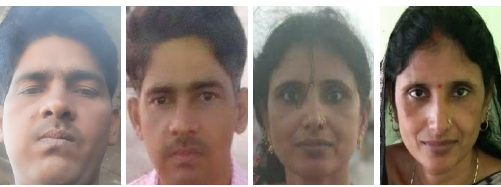
Figure 3. Examples from collected YALEb database